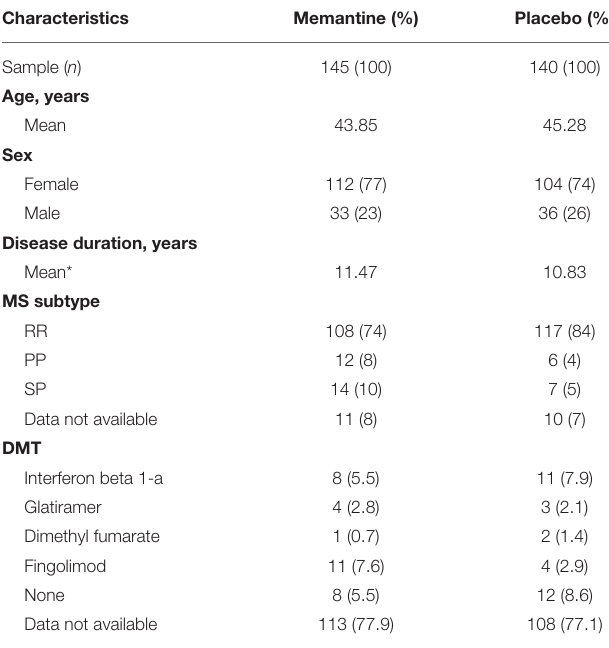
TABLE 2 | Characteristics of patients in the included studies ( N = 285). Characteristics